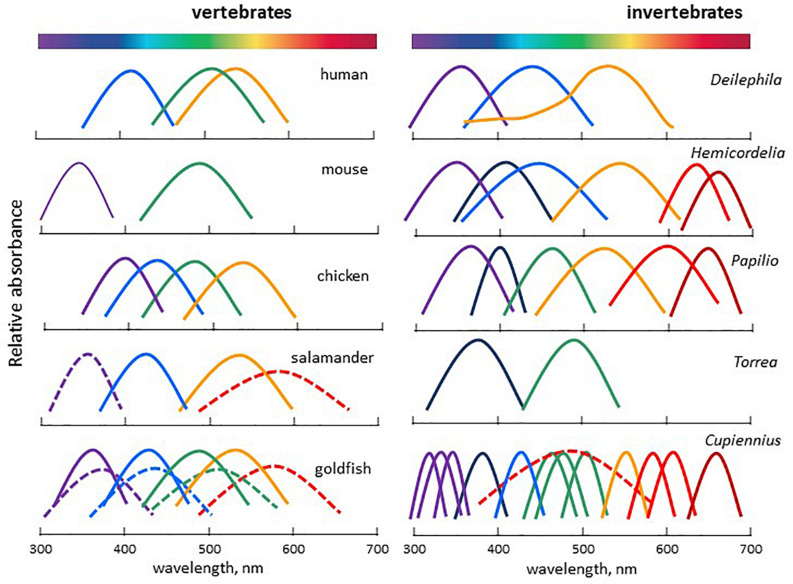
Spectral sensitivity curves of selected vertebrate and invertebrate representatives, illustrating the wide variety of light detection systems encountered. Vertebrates: human Homo sapiens, mouse Mus musculus, chicken Gallus domesticus, Salamander Salamandra, goldfish Carassius auratus. Invertebrates: elephant hawk moth Deilephila elpenor, dragonfly Hemicordulia tau, butterfly Papilio xuthus, annelid worm Torrea candida, nocturnal spider Cupiennius salei. Adapted and modified from Imamoto and Shichida (2014), Warrant (2019).